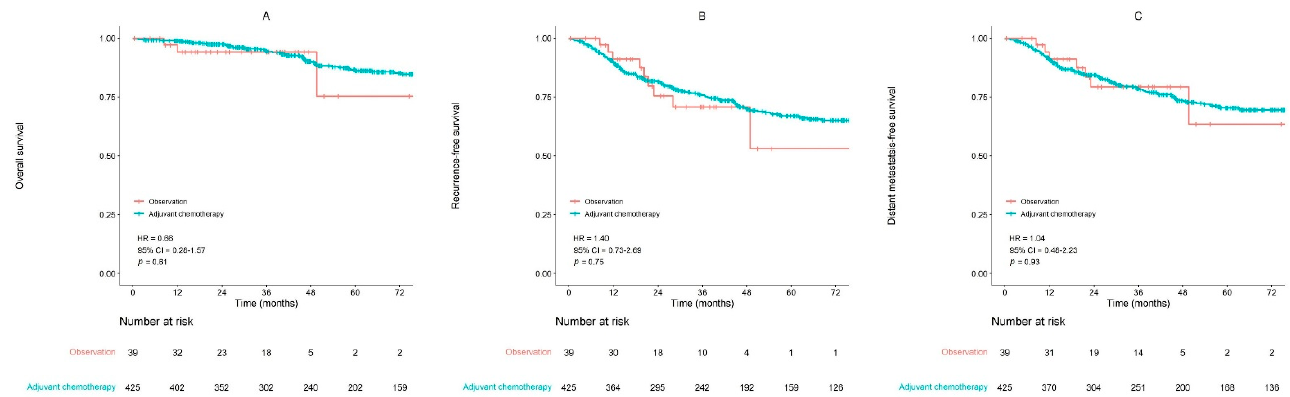
Figure 3. Survival curves in low-risk group. ( A ) Overall survival; ( B ) Recurrence-free survival; ( C ) Distant metastasis-free survival (HR, hazard ratio; CI, confidence interval).